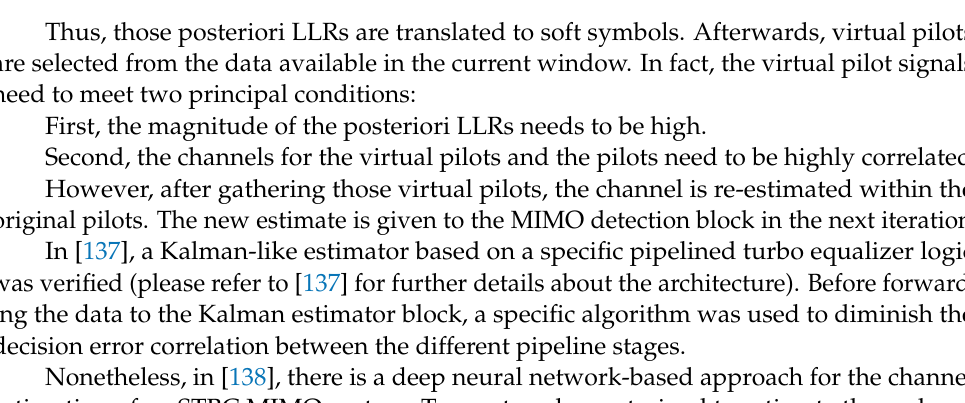
Figure 19. Channel iterative estimation